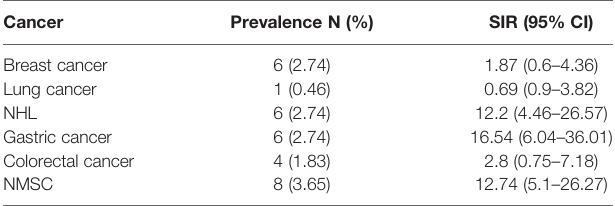
TABLE 2 | Prevalence and SIR for different types of cancer in a cohort of 219 CVID